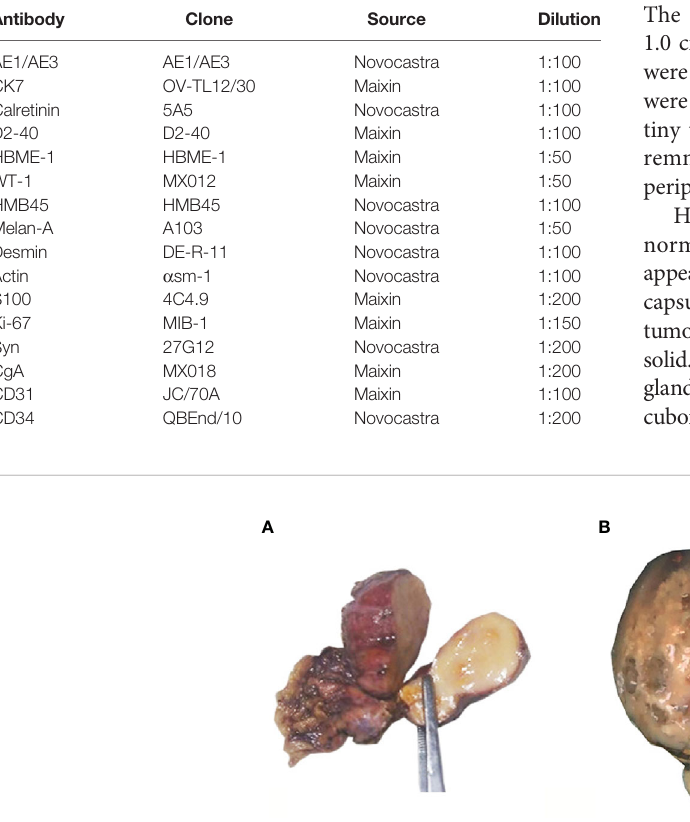
FIGURE 1 | Gross examination of adrenal AT. (A) The tumor of case No. 1 measured 3.5 × 2.0 × 1.0 cm in size. Cut surface showed a solid, grayish yellow tumoral lesion. (B) The tumor of case No. 2 measured 8.0 × 6.5 × 3.0 cm in size. On cut surface, the tumor was solid, grayish yellow with some tiny thin-walled, translucent cysts. Small remnants of normal adrenal tissues were perceived at the